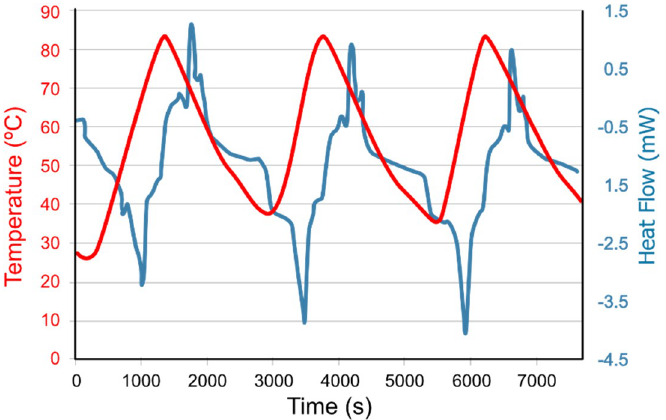
Figure 3. TG-DSC (Thermogravimetry-Differential Scanning Calorimeter) curves for sample 3.